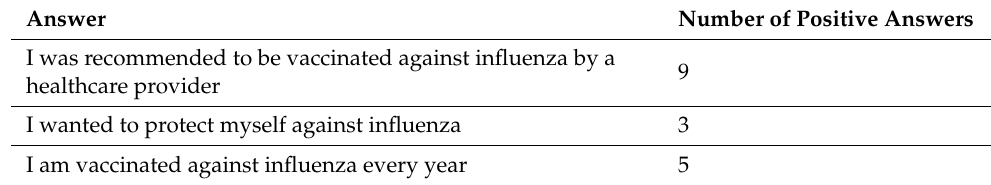
Table 2. Main reason to be vaccinated against influenza—patients who received the flu shot—17. Answer